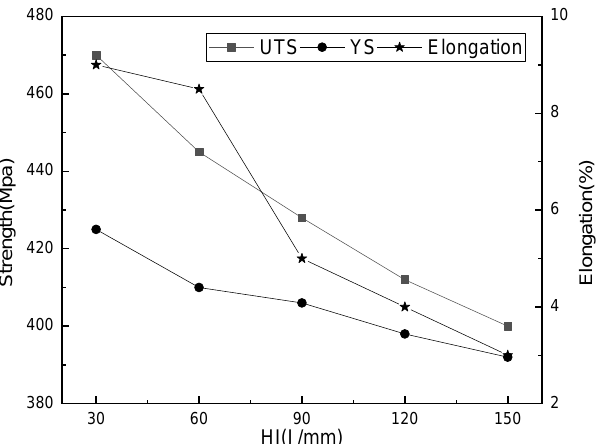
Figure 9. Mechanical properties of deposits with different heat input.